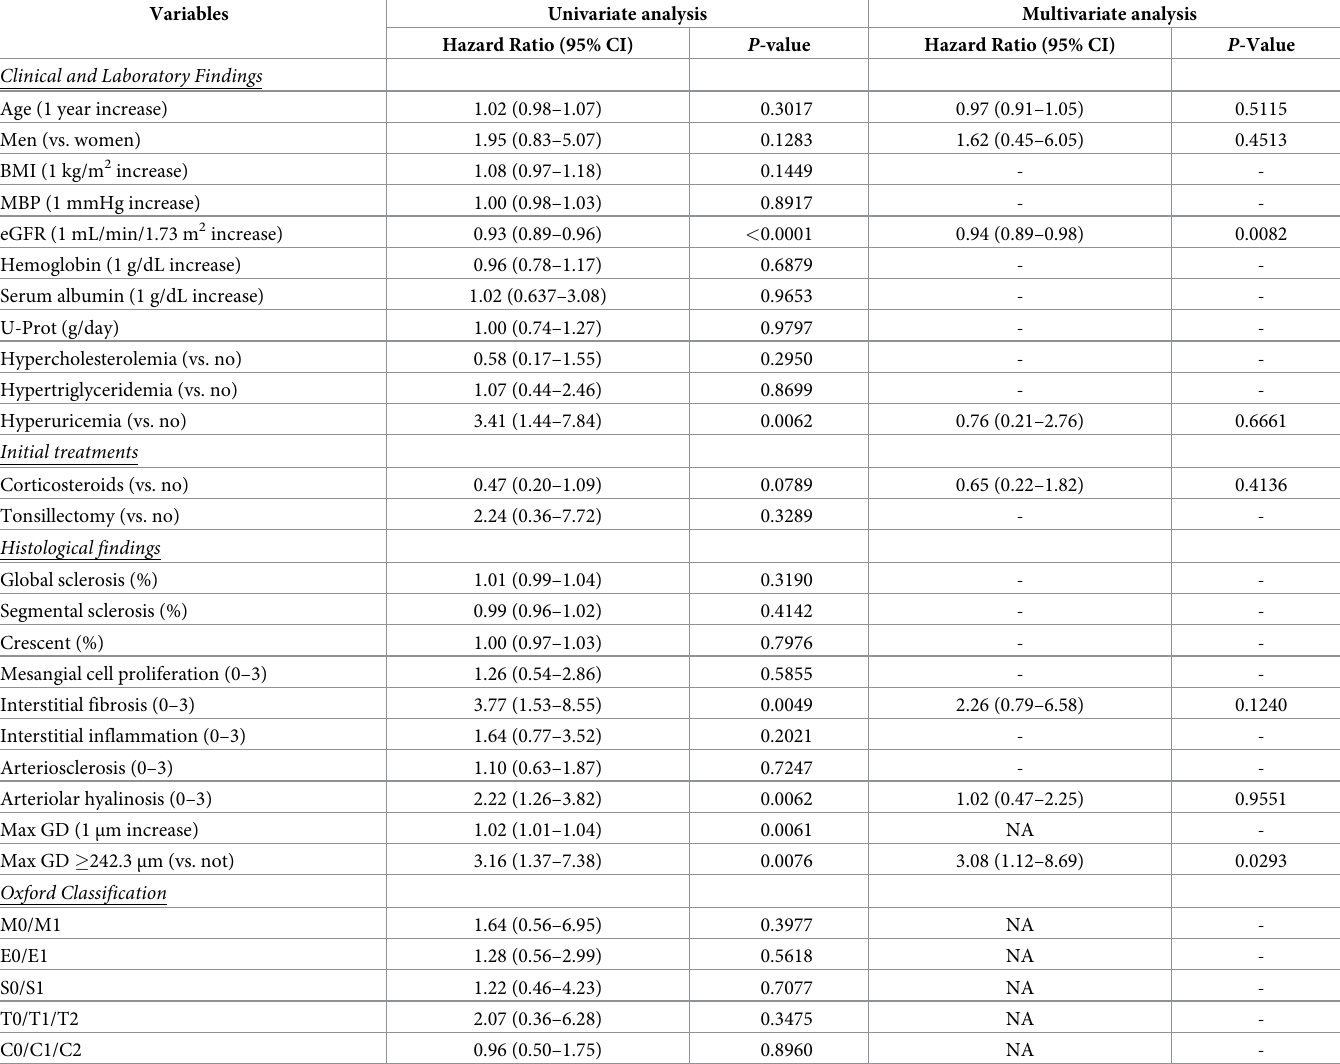
Table 2. Univariate and multivariate analysis of risk factors associated with a � 50% eGFR decline or ESRD (Entire cohort, n = 43).